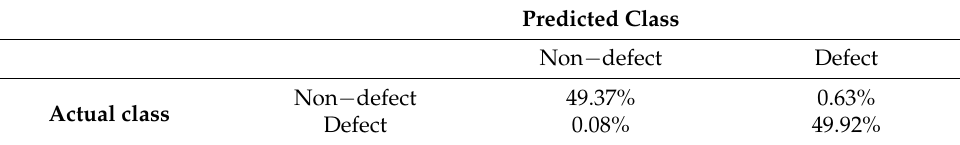
Table 2. The confusion matrix for numerical data.